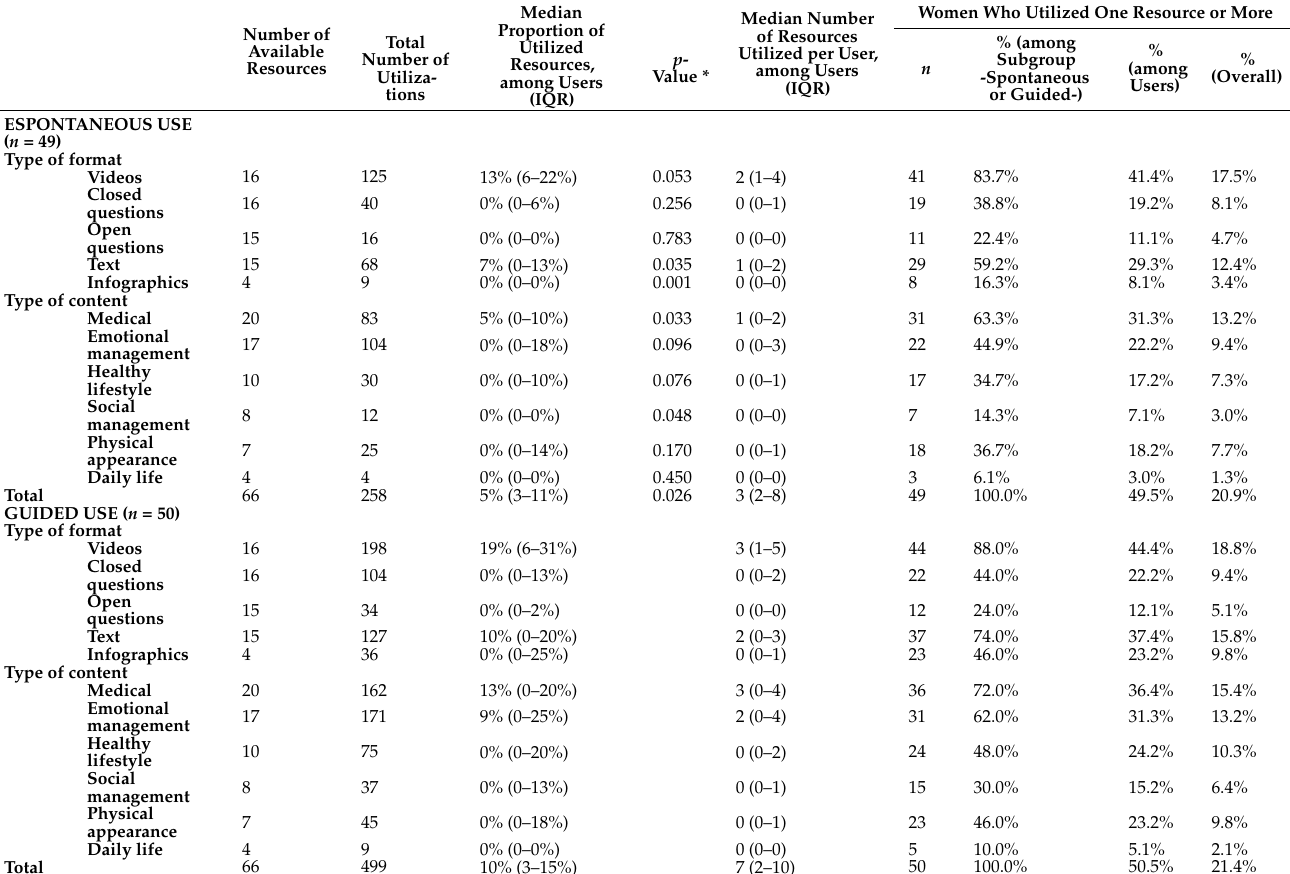
Table 3. Use of resources among users by type of use: guided use vs. spontaneous